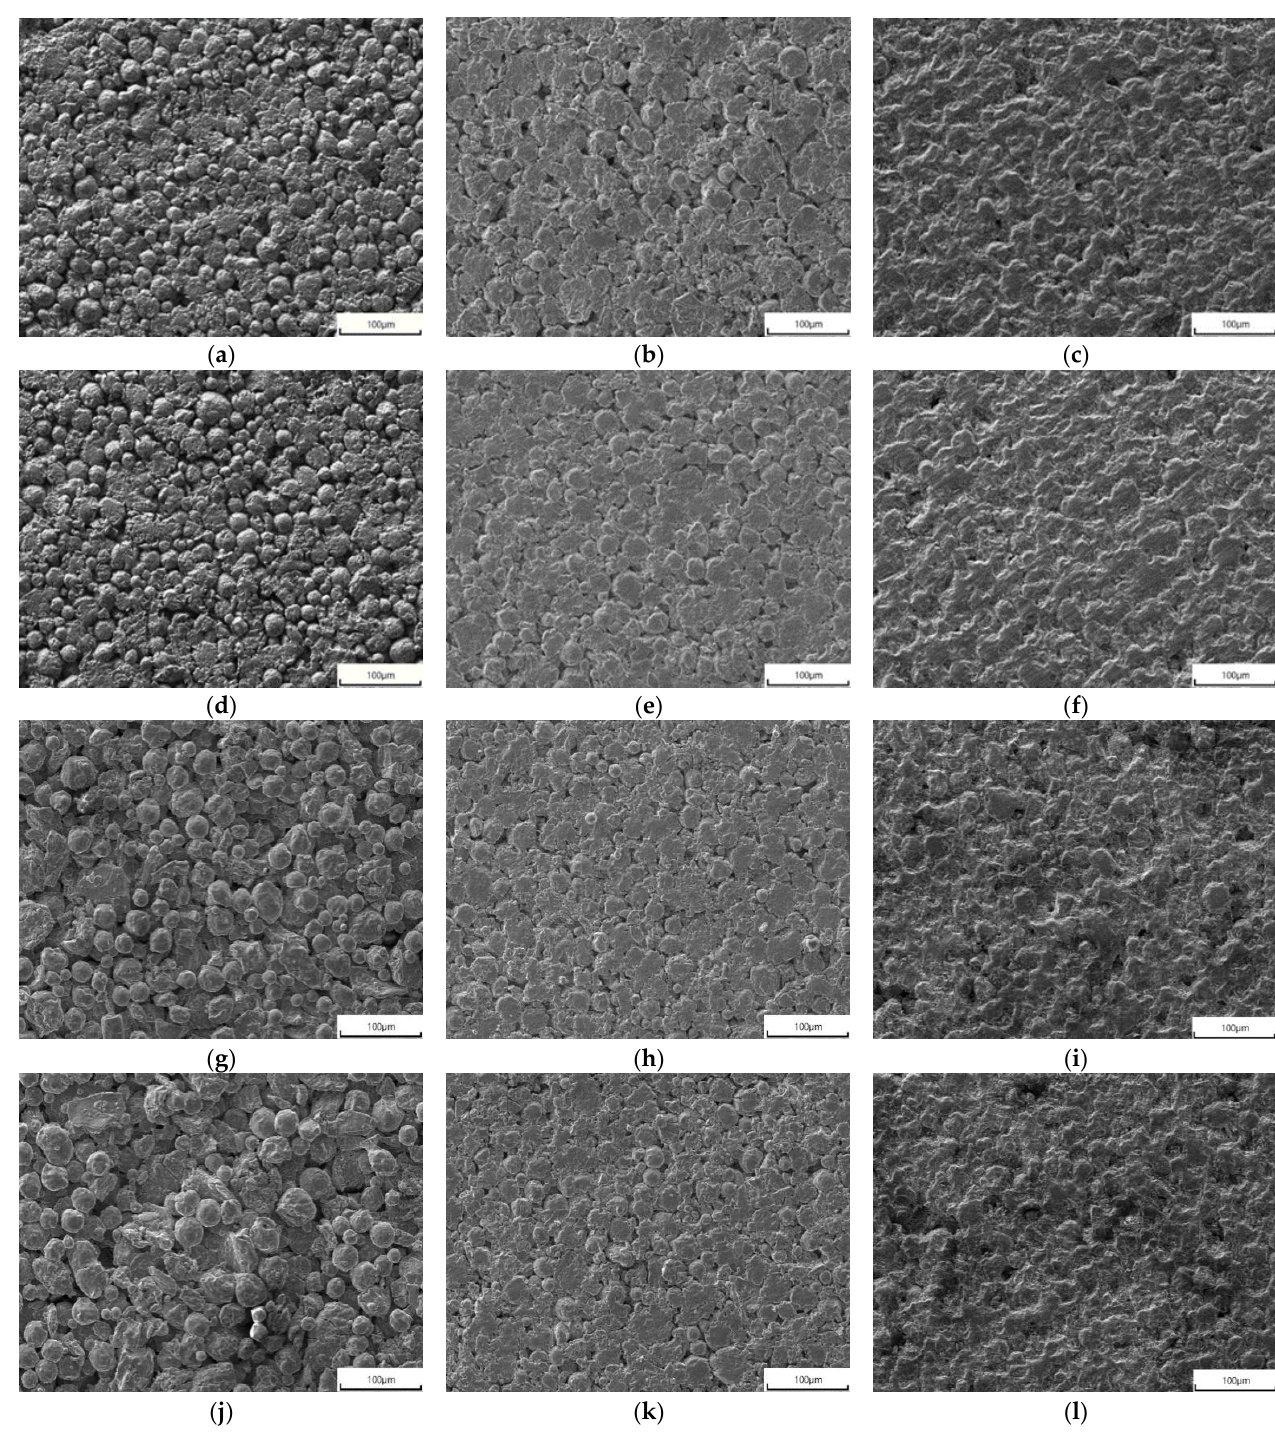
Figure 2. Microstructure of the sintered 8YSZ bulk at 1650 °C for 6 h ( a ), 12 h ( b ), and 24 h ( c ); microstructure of the sintered GYYZO bulk with 5 wt% Yb 2 O 3 and 5 wt% Gd 2 O 3 at 1650 °C for 6 h ( d ), 12 h ( e ), and 24 h ( f ); microstructure of the sintered GYYZO bulk with 5 wt% Yb 2 O 3 and 10 wt% Gd 2 O 3 at 1650 °C for 6 h ( g ), 12 h ( h ), and 24 h ( i ); microstructure of the sintered GYYZO bulk with 5 wt% Yb 2 O 3 and 15 wt% Gd 2 O 3 at 1650 °C for 6 h ( j ), 12 h ( k ), and 24 h ( l ). The image processing method was used to determine the porosity of the sintered bulks through ImageJ Software @ with the results listed in Table 3. With the prolongation of the sintering time, the porosity of the sintered bulks gradually decreased. The bulk